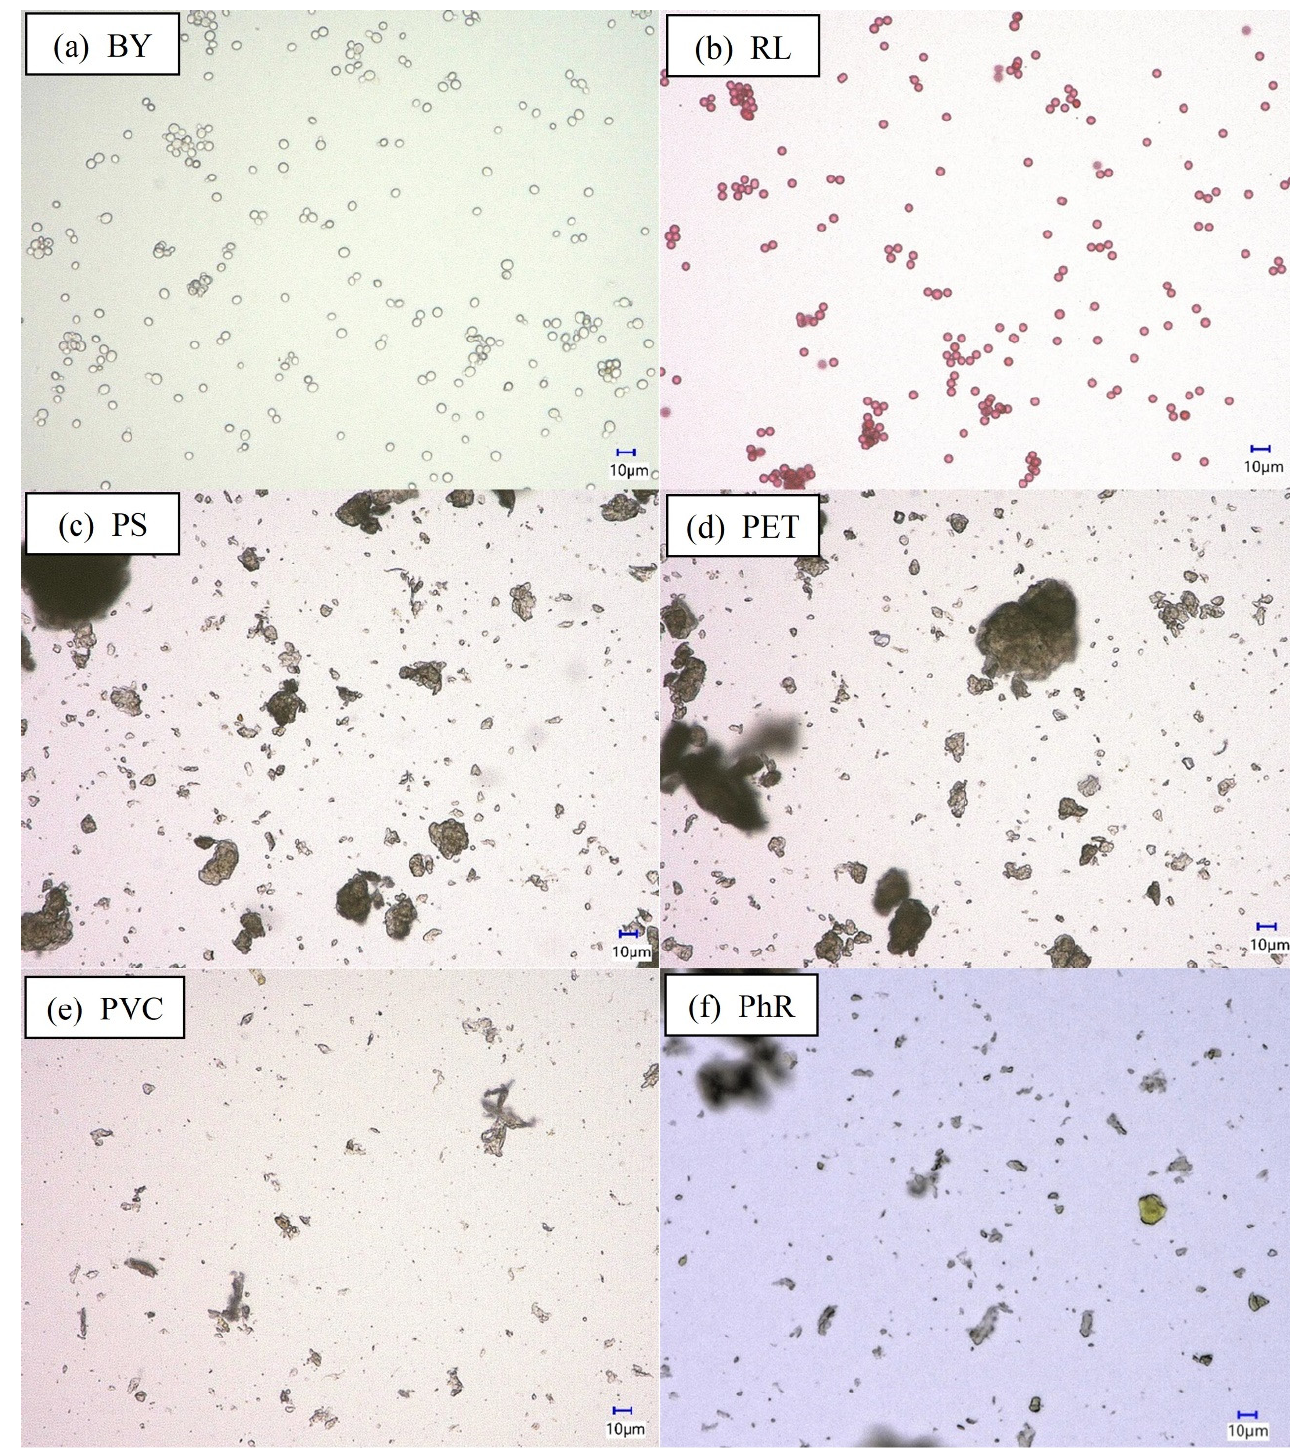
Figure 2. Microphotographs of the used microparticles: ( a ) BY; ( b ) RL; ( c ) PS; ( d ) PET; ( e ) PVC; ( f ) PhR.